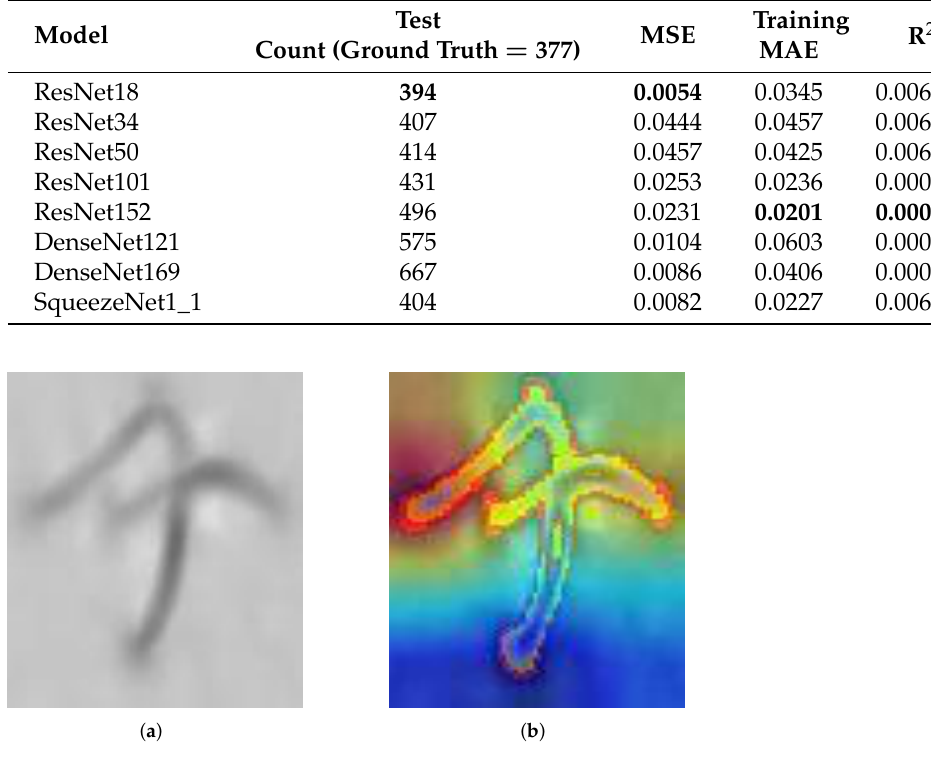
Table 3. Performance statistics on unseen test data (second column), and training statistics (columns